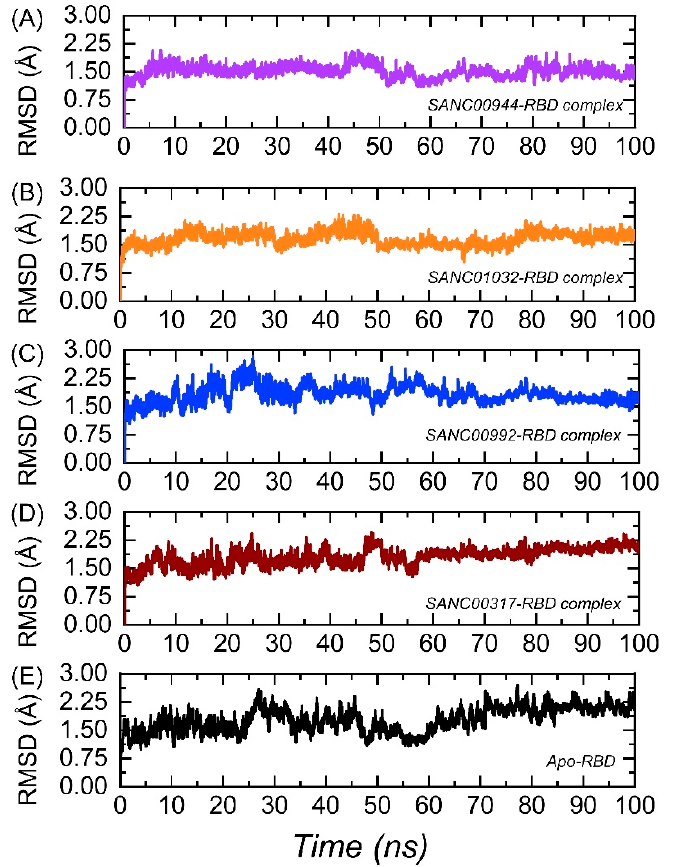
Figure 6. Dynamic stability analysis of the top hits in complex with the RBD: ( A ) the root-mean- square deviation (RMSD) of the SANC00944–RBD complex; ( B ) the RMSD of the SANC01032–RBD complex; ( C ) the RMSD of the SANC00992–RBD complex; ( D ) the RMSD of the SANC00317–RBD complex; ( E ) the RMSD for the Apo RBD.